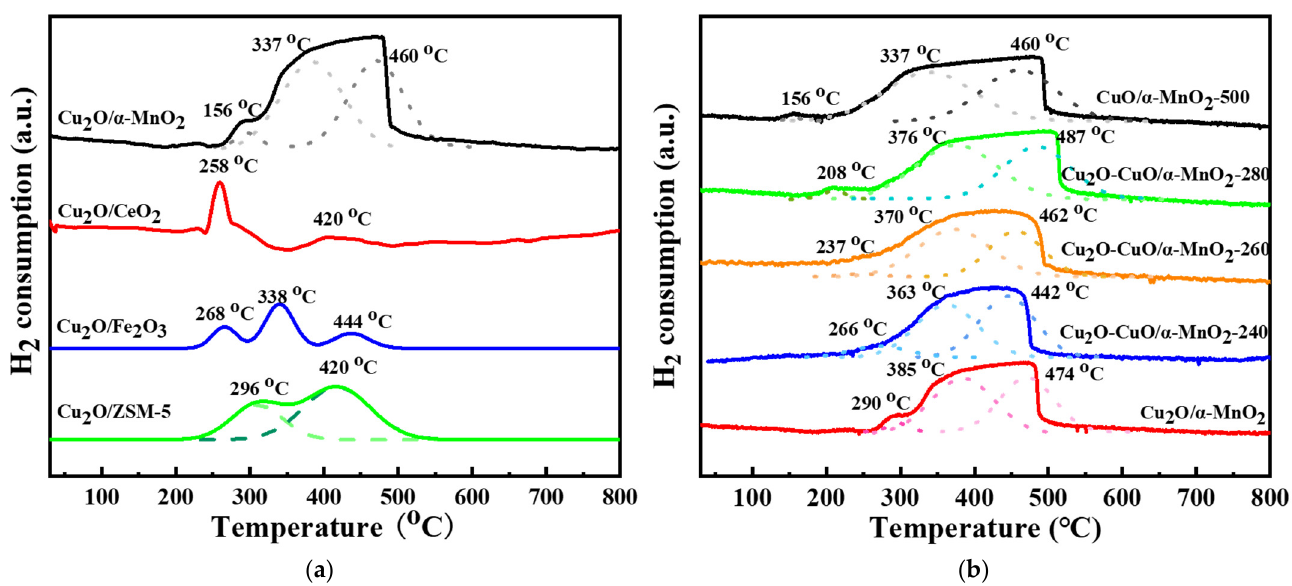
Figure 13. H 2 -TPR profiles of the as-prepared ( a ) Cu 2 O/S (S = ZSM-5, CeO 2 , α -MnO 2 , and Fe 2 O 3 ) catalysts and ( b ) α -MnO 2 , Cu 2 O/ α -MnO 2 , Cu 2 O-CuO/ α -MnO 2 -T, and CuO/ α -MnO 2 -500 catalysts. The H 2 reduction profiles of the Cu 2 O/ α -MnO 2 , Cu 2 O-CuO/ α -MnO 2 -T, and CuO/ α